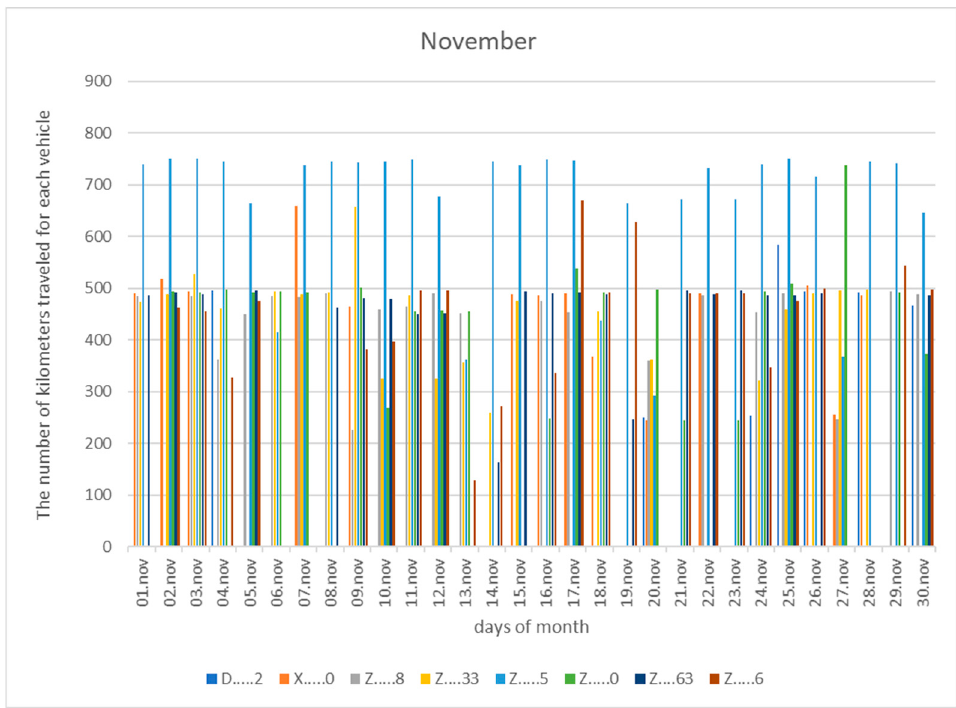
Figure 7. The number of kilometres travelled for each vehicle in